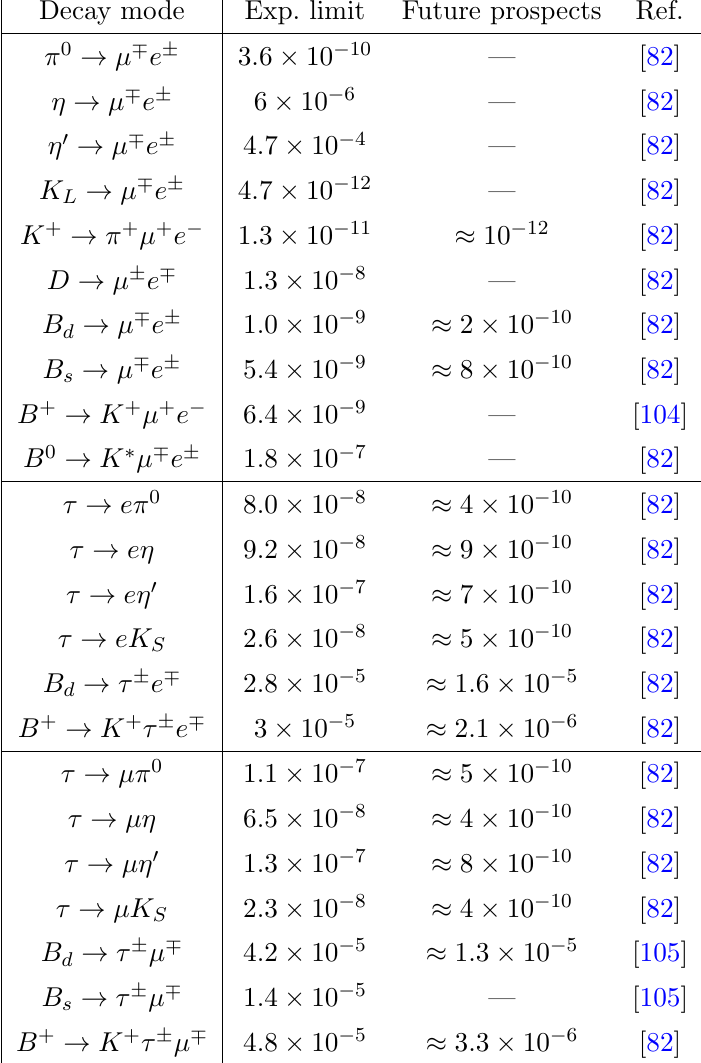
Table 4 . Most relevant experimental limits on LFV (cid:28) and leptonic meson decays [82] and future prospects for NA62 [41], LHCb [42, 90] and Belle-II [43, 91]. which can be understood from the fact that (cid:28) ’s can only decay through weak interactions, di(cid:11)erently than (cid:25) 0 and (cid:17) ( 0 ) . For that reason, (cid:28) decays are much better probes of new physics than light-meson